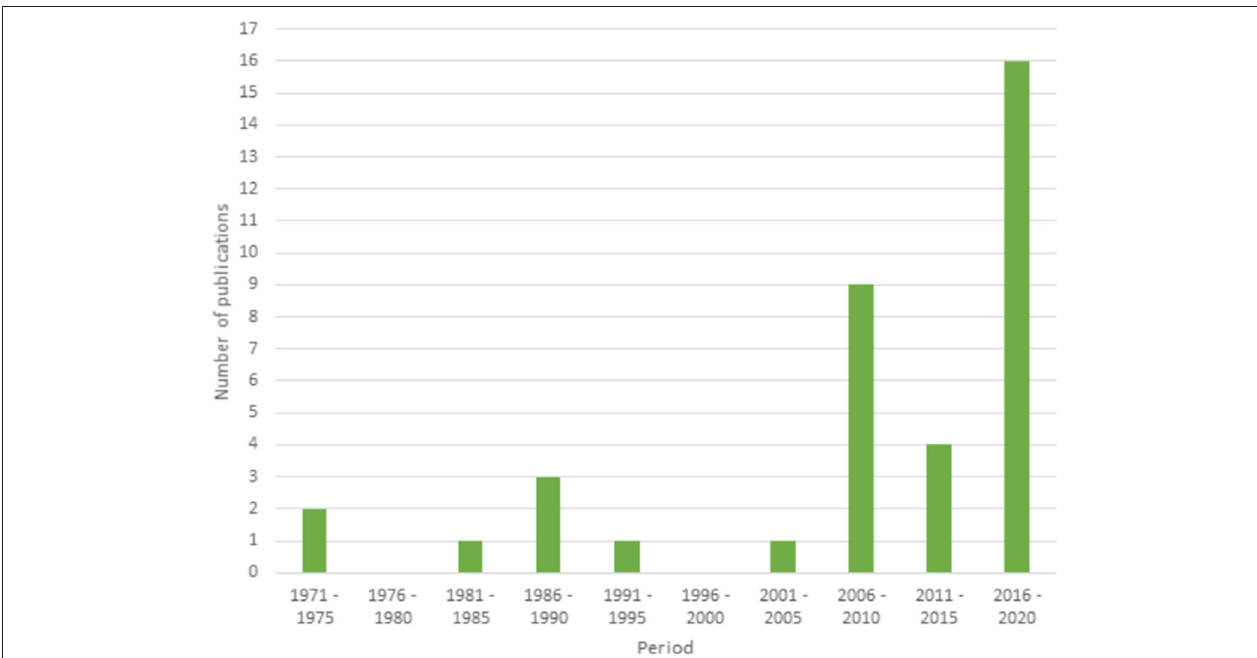
FIGURE 2 | Number of publications on sand-storage dams in the last 50